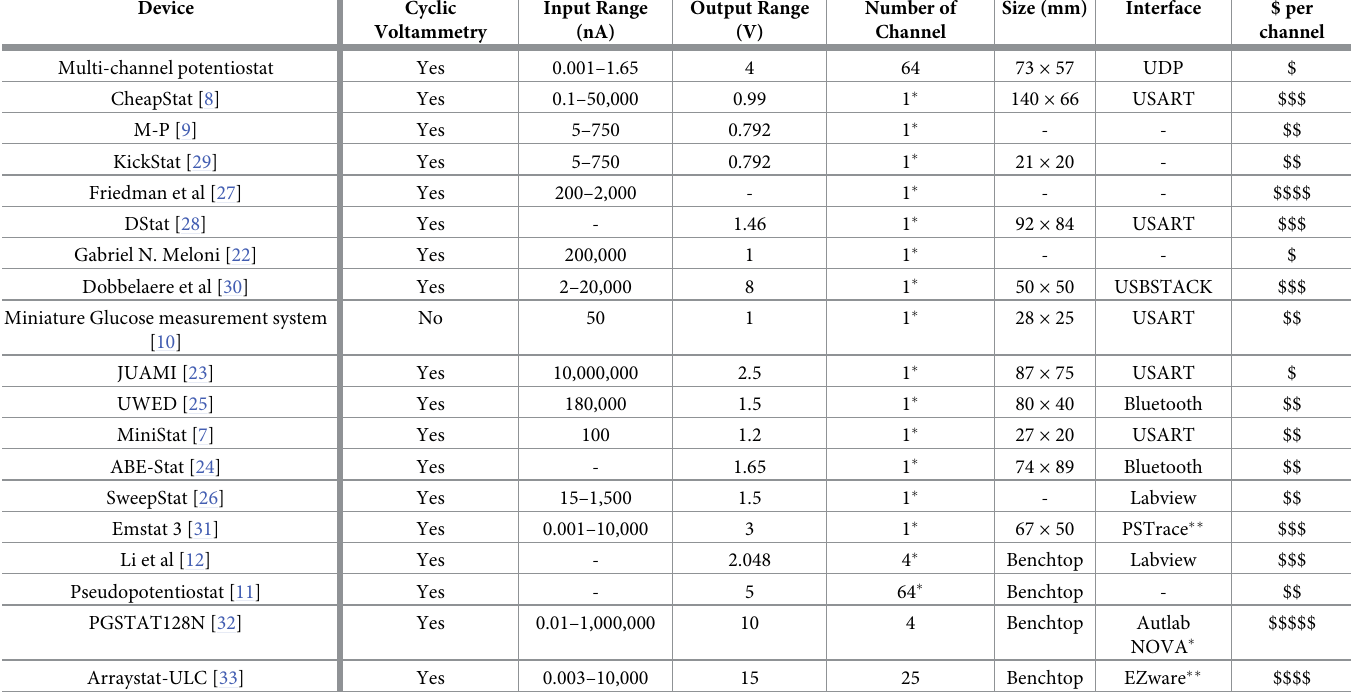
Table 1. The multi-channel potentiostat in comparison with other potentiostat devices.